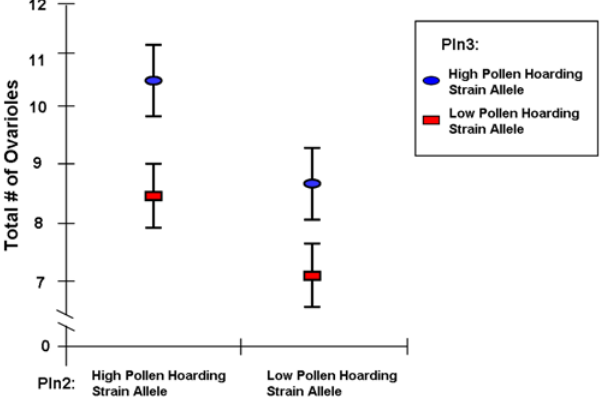
Figure 1. Effects of pln -QTL on ovary size. Behavioral pln2 and pln3 QTL showed direct, additive genetic effects on the total number of worker ovarioles (mean 6 s.e.m.) in a high strain backcross between the selected pollen-hoarding strains.